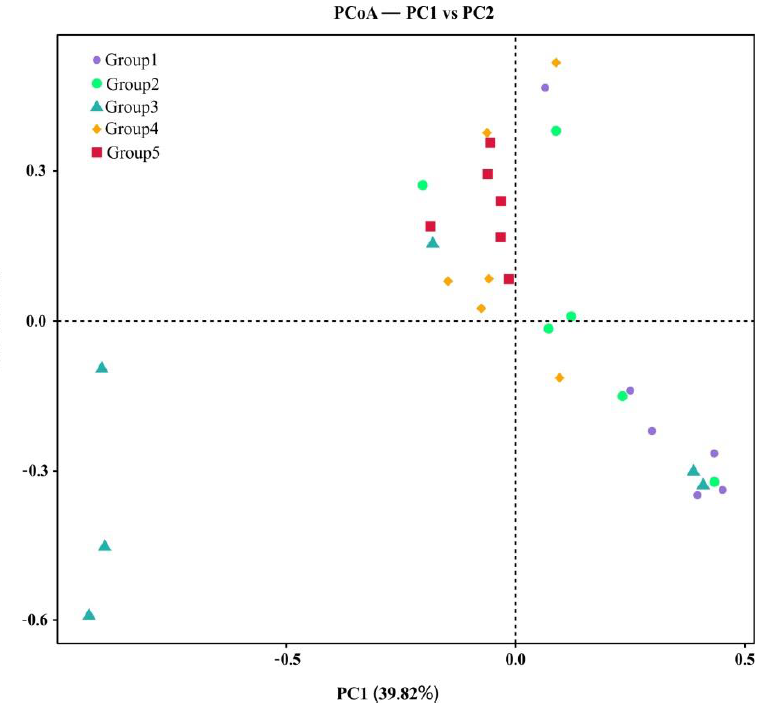
Figure 4. PCoA (weighted − UniFrac distance) of S. palustre endophytes in the Erxianyan peatland.